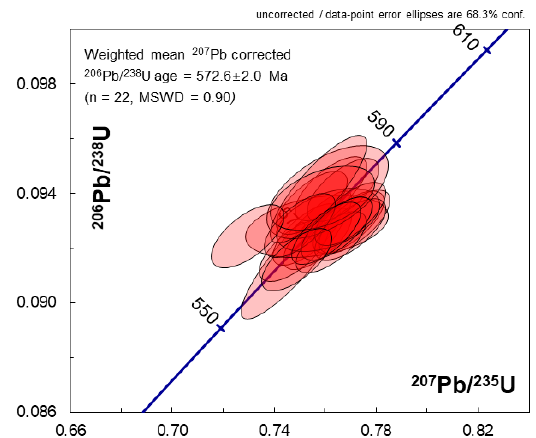
Figure 2. 206 Pb / 238 U- 207 Pb / 235 U concordia diagram showing the SHRIMP results for the LKZ-1 zircon Figure 2. 206 Pb/ 238 U- 207 Pb/ 235 U concordia diagram showing the SHRIMP results for the LKZ-1 zircon with ± 1 σ error ellipses. The plotted data are uncorrected for common with ±1 σ error ellipses. The plotted data are uncorrected for common Pb. Table 2. SHRIMP U–Th–Pb results for the LKZ-1 zircon. Spot No.